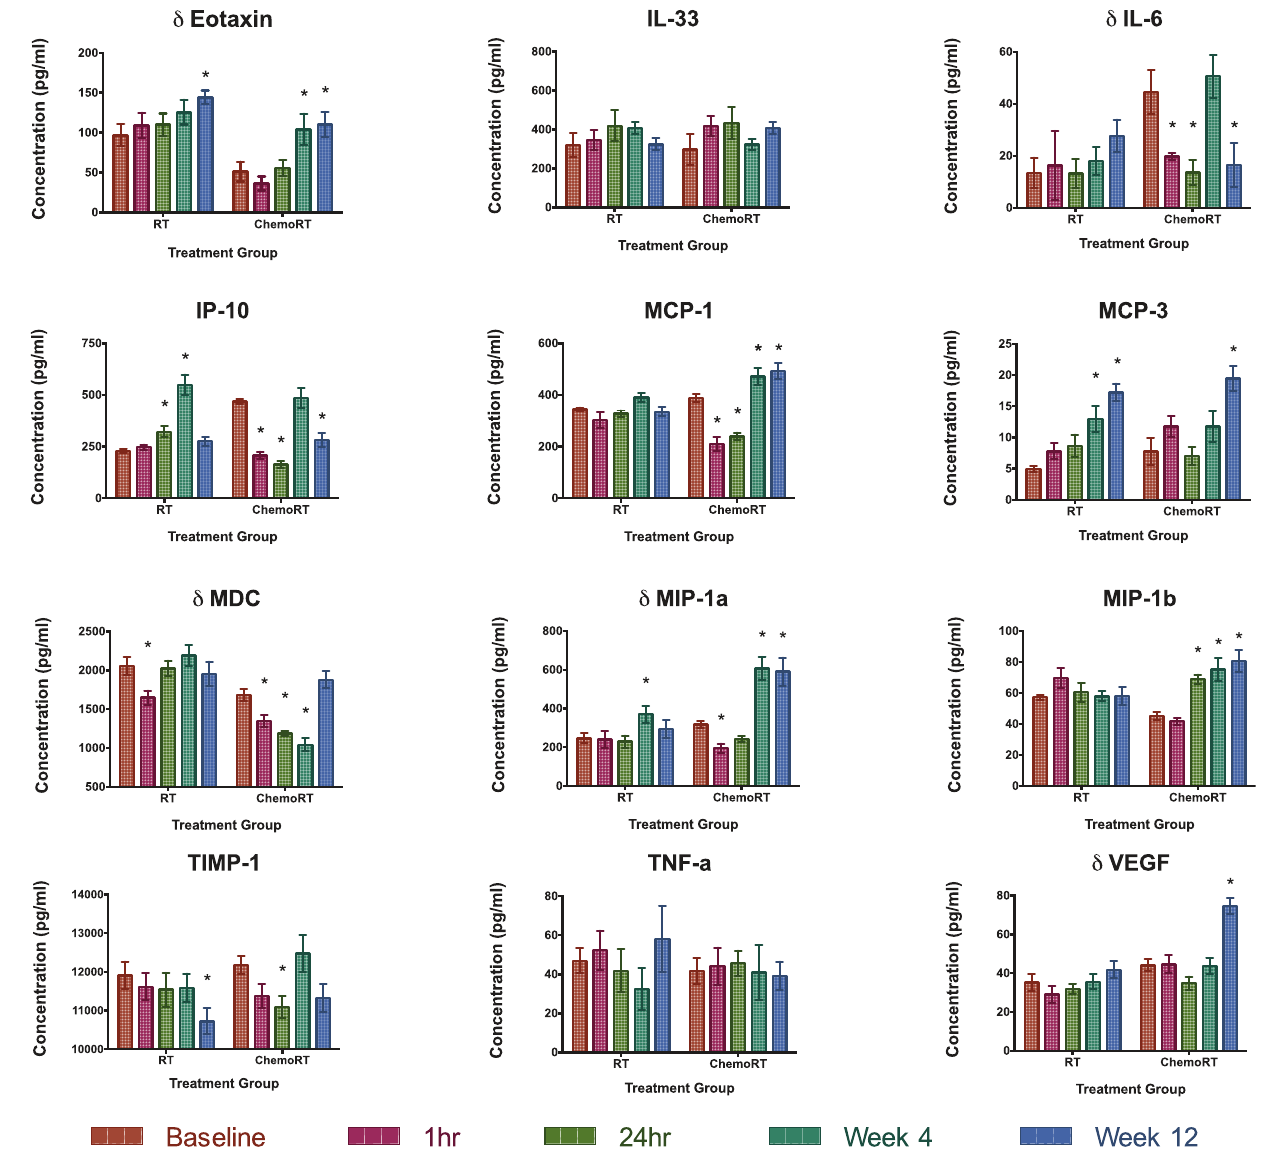
Figure 1. Mean plasma ( + / 2 standard error) cytokine levels at each time point during radiotherapy (1-hour, 24-hours, 4-weeks) and after radiotherapy (12-weeks). Levels are grouped into treatment type (ChemoRT vs RT alone). Cytokines in which the variation is different dependent upon treatment groups are marked with a delta ( d ). Within each cytokine graph, an asterisk ( * ) denotes at which time the level of plasma cytokines are significantly different from the baseline level, with corrections for multiple comparisons performed using Dunnett’s